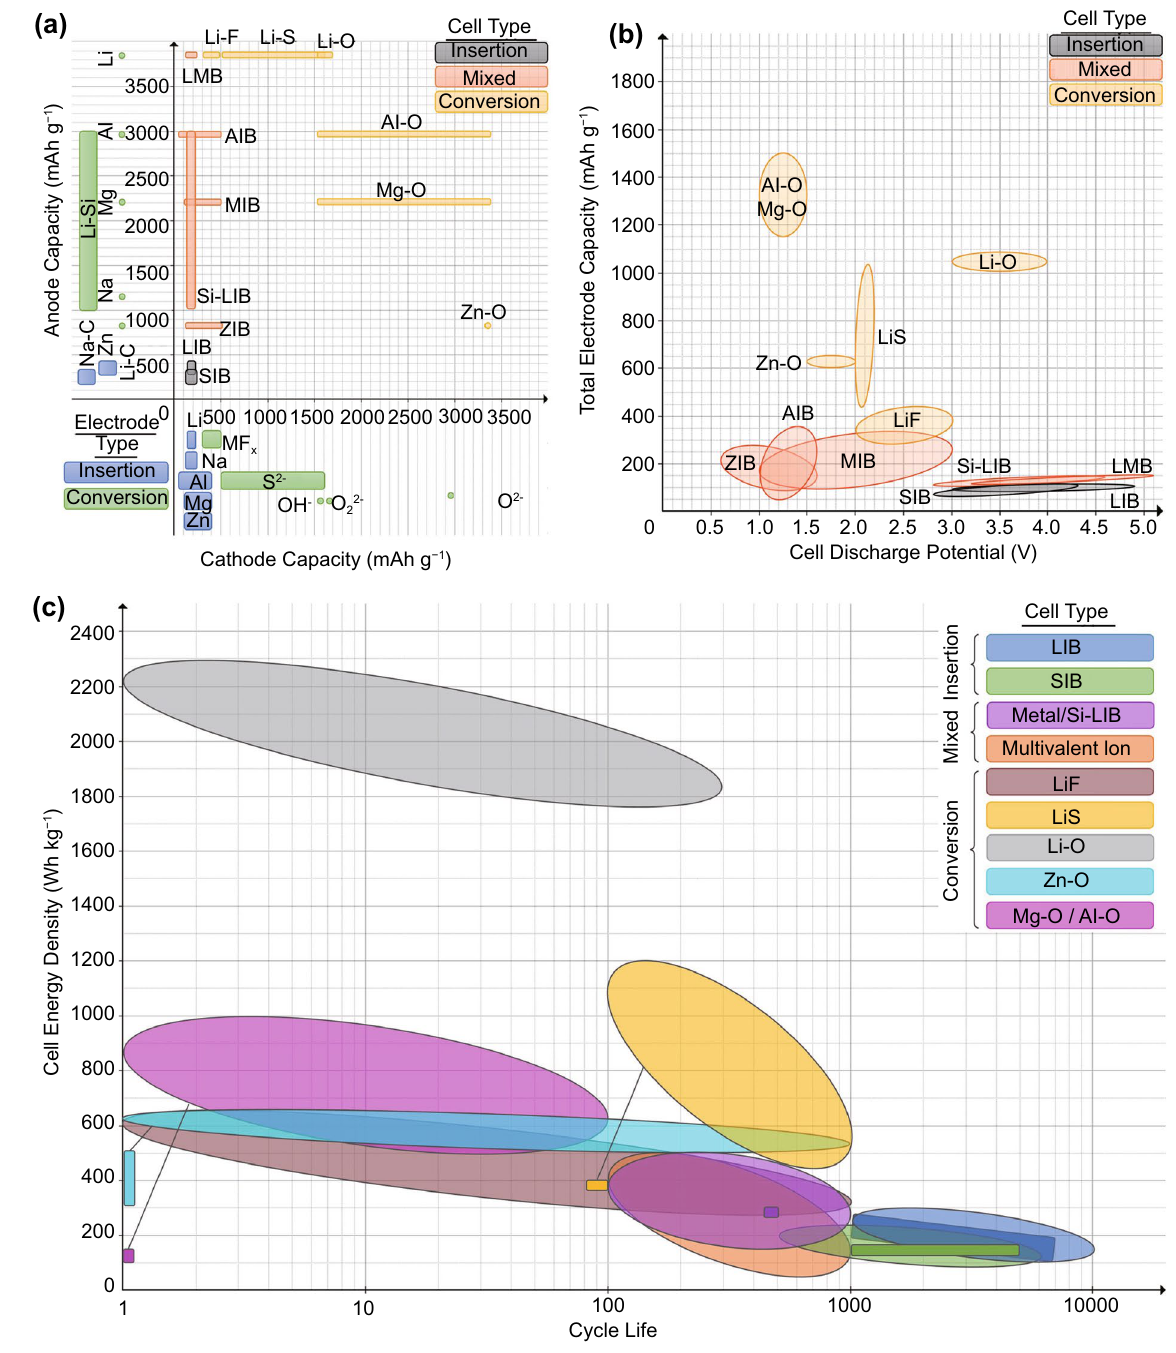
Fig. 18 General maps showing a charge capacities of various anodes and cathodes along with promising battery chemistries that can be formed from their combination. The charge capacities of metallic anodes and oxygen cathodes are their theoretical values, while all other electrodes are reported values in academia as covered in this review. For consistency, all active ion masses for insertion electrodes are assigned to the anode. b Total electrode capacities calculated from a for the aforementioned combinations, plotted against reported discharge voltages as covered in this review. c Cell energy densities calculated from b assuming 50% inactive mass, plotted against reported cycle lives as covered in this review. The faded oval regions represent the general performance of the cell chemistry as reported in academia, while solid rectangular regions represent the performance of commercially available cells [36, 37, 210, 247–256] , illustrating the gaps between